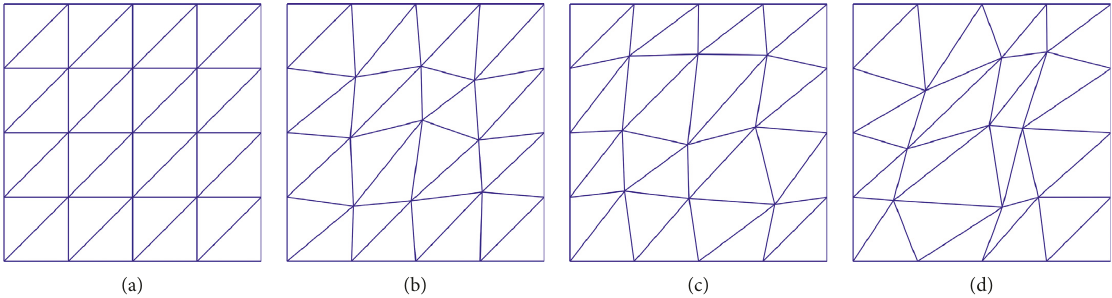
. 2; (c) irregularity coefficient α r (cid:31) 0